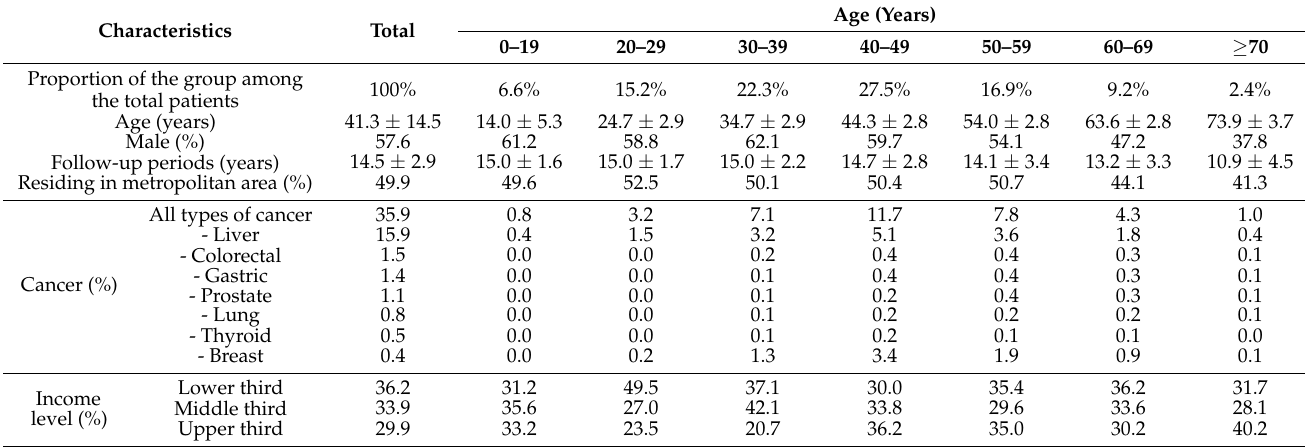
Table 1. Baseline characteristics of linked-to-care chronic hepatitis B patients.